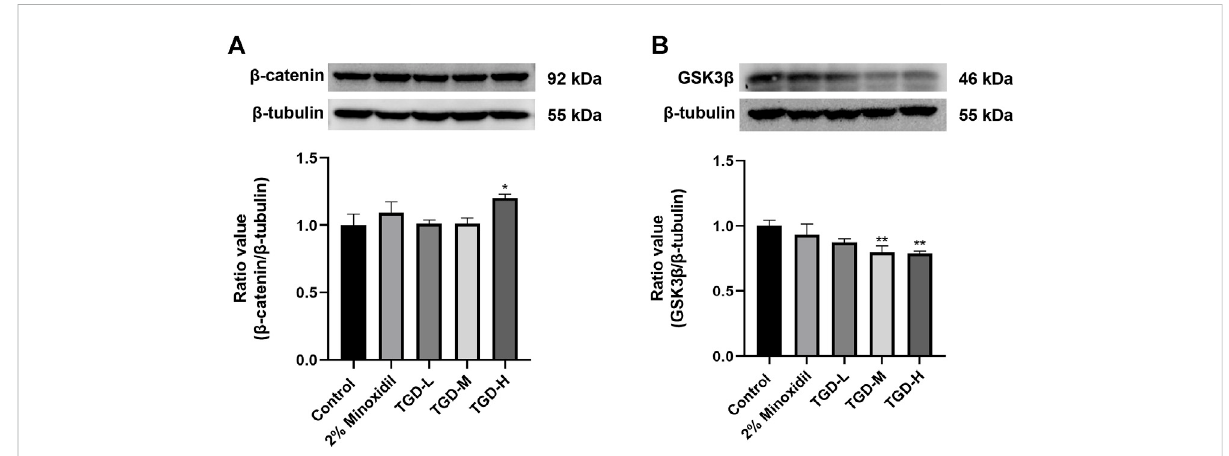
FIGURE 10 (A,B) ExperimentalvalidationoftheWnt/ β -cateninsignalingpathways invivo ( n =5).Thedataareexpressedasthemean±SEM.* p < 0.05,** p < 0.01, and *** p < 0.001 vs. the control